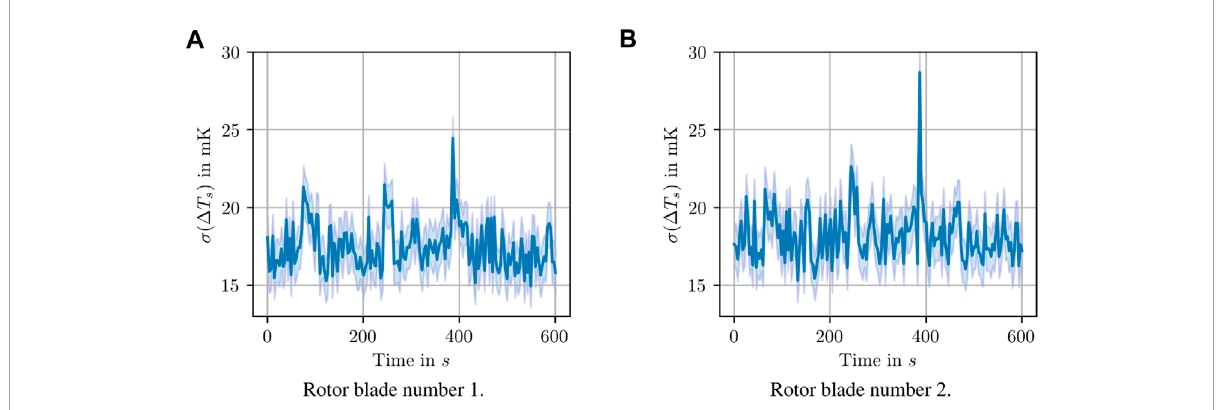
approach for an IRT-based identification of time steps with potential unsteady flow separation events is